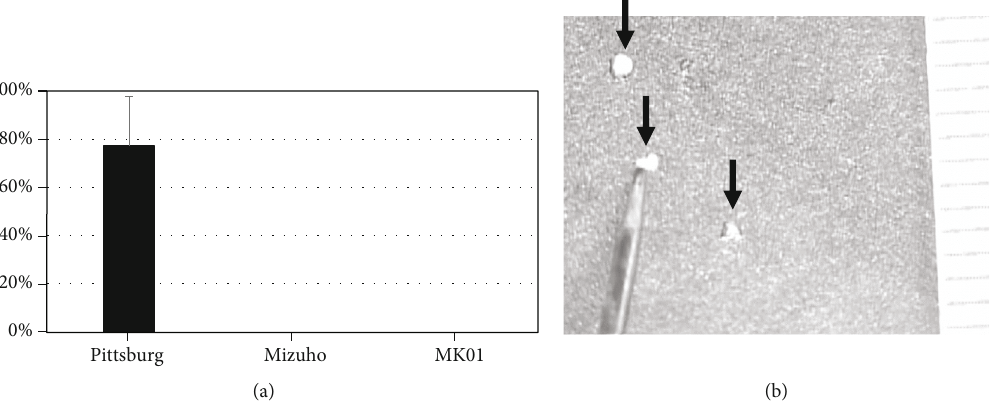
Figure 3: Amount of brain debris found in each cannula (a) and representative fi gure of the debris (b,